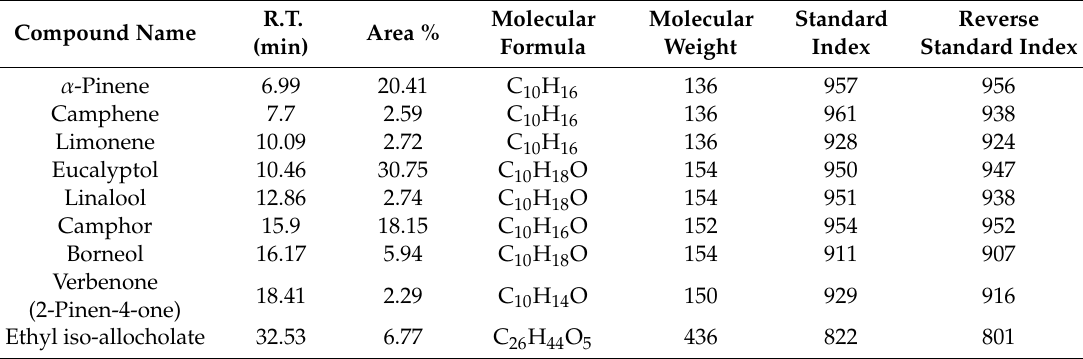
Table 3. Chemical composition of the EO from R. o ffi